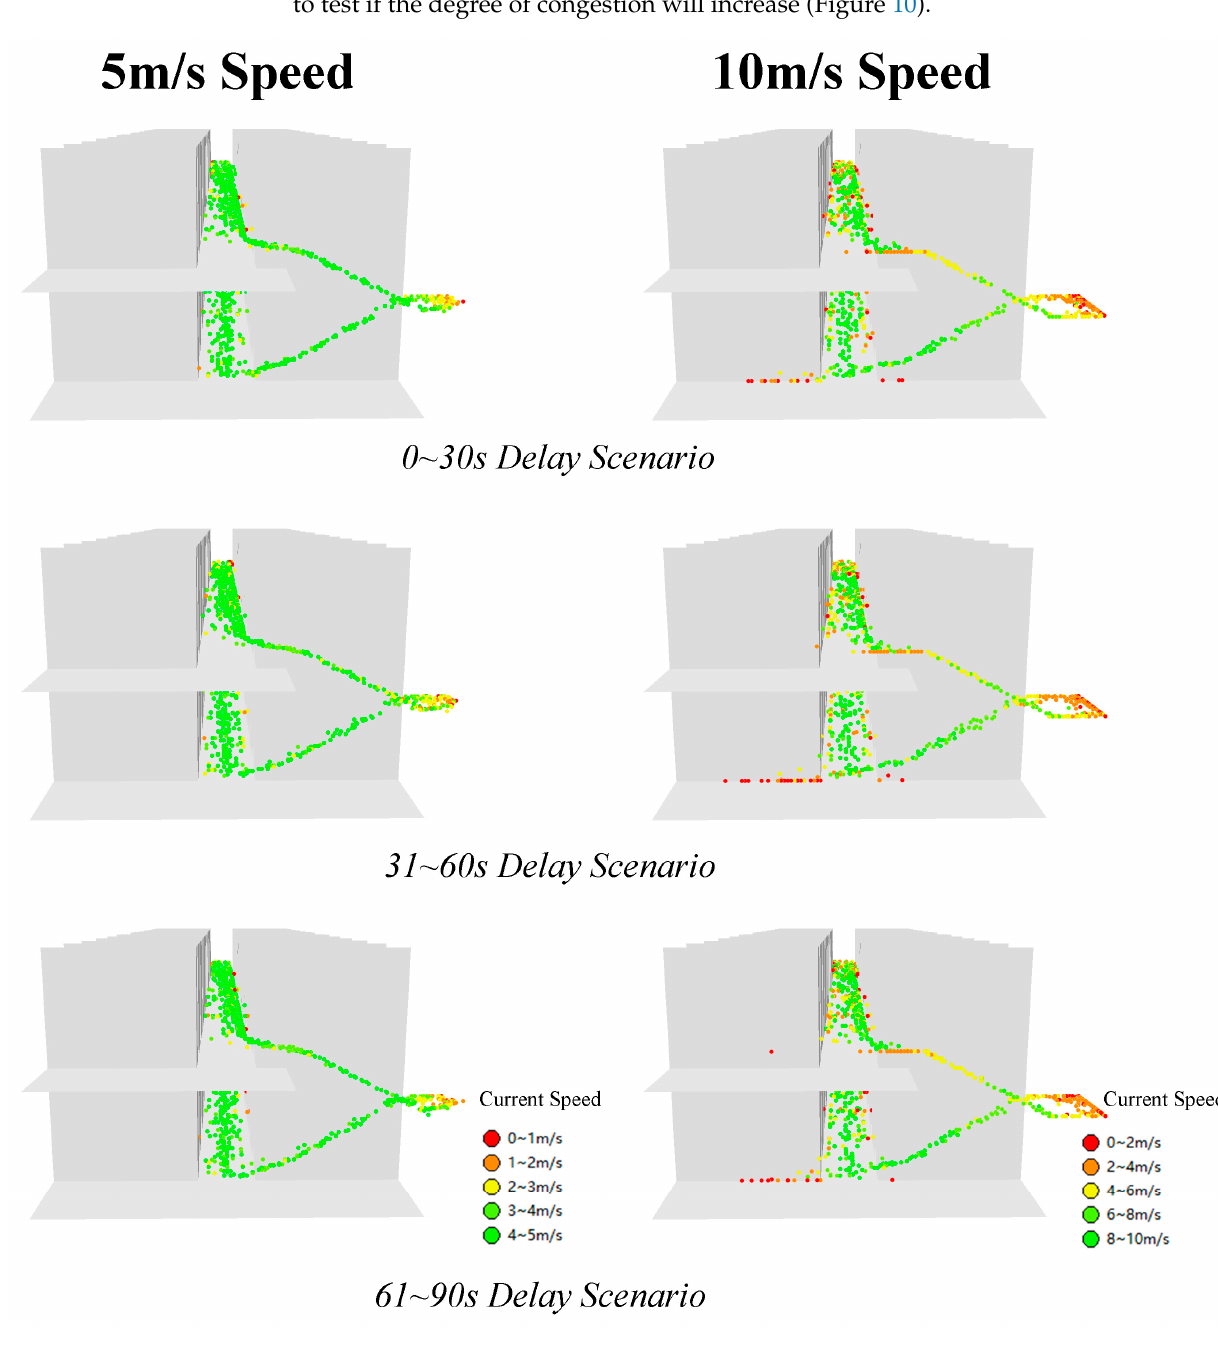
Figure 10. Comparison of congestion at different speeds under a different delay time scenario.